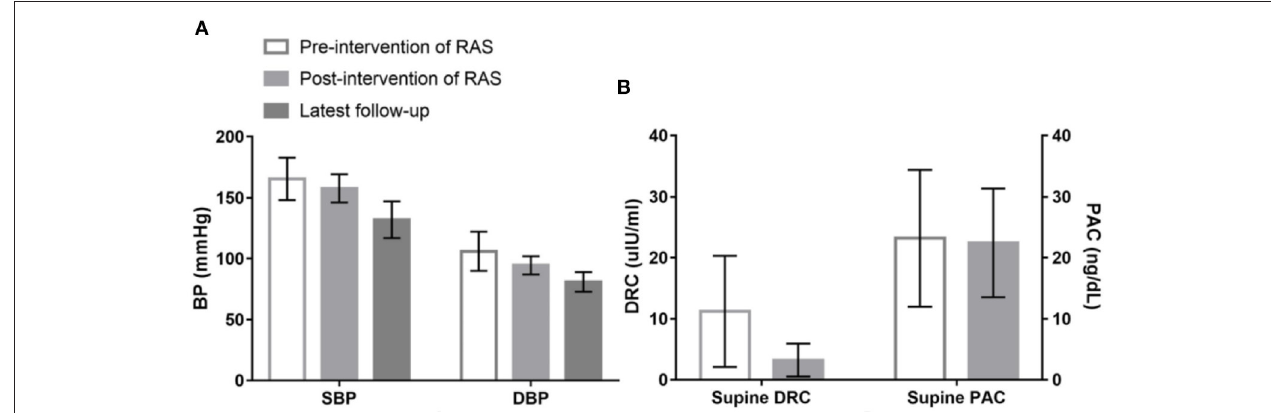
FIGURE 2 | Changes of systolic blood pressure (SBP), diastolic blood pressure (DBP), supine direct renin concentration (DRC) and plasma aldosterone concentration (PAC) among patients underwent revascularization treatment of renal artery stenosis (RAS). (A) Shows that compared with the measured values before revascularization treatment for RAS, both SBP (166 ± 17 vs. 158 ± 12 mmHg; P = 0.005) and DBP (106 ± 16 vs. 94 ± 8 mmHg; P < 0.001) were significantly decreased after revascularization treatment, and SBP and DBP further decreased to 132 ± 15 and 81 ± 8 mmHg, respectively, when those patients received targeted treatment for PA during the latest follow-up. (B) Shows that supine DRC lowered from 11.22 ± 9.10 to 3.24 ± 2.69 uIU/ml ( P < 0.001) compared with the baseline levels before revascularization treatment for RAS; however, no significant difference was observed in PAC (23.22 ± 11.20 vs. 22.45 ± 8.90 ng/dL; P = 0.697).